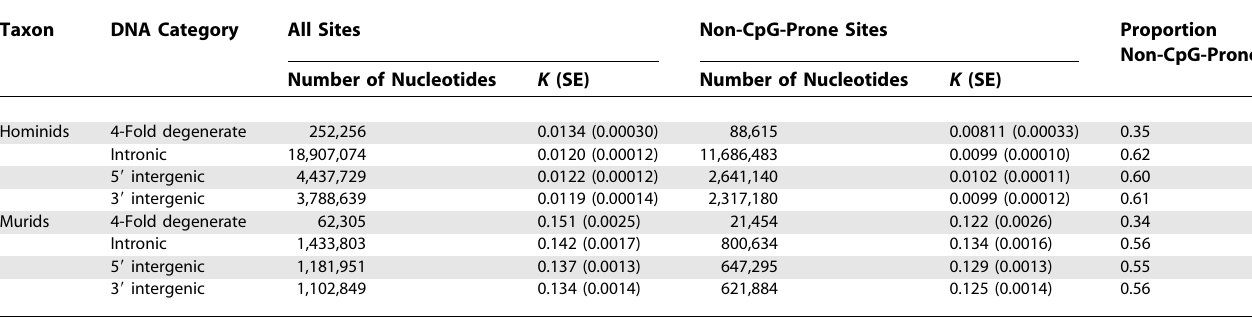
Table 1. Summary Statistics for Sequences Sampled from Hominid and Murid Genomes Taxon DNA